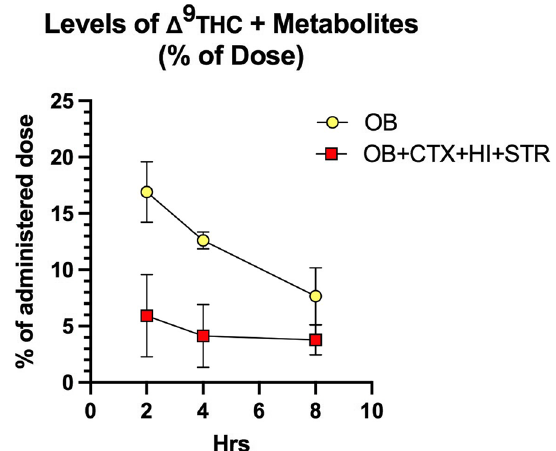
Fig. 5 Percent of administered dose that accumulates in the brain tissues over time. Ratio (expressed as %) of mean OB concentrations to administered dose is shown in yellow circles. Percent of dose accumulated in all 4 brain regions was determined by calculating the ratio of the mean of 4 brain region concentrations of Δ 9 THC metabolites to the administered dose of Δ 9 THC (268 μg/g). Two‑way ANOVA revealed that brain regions contributed 26.9% of total variation (* p <0.005) and time contributed only 9.5% of total variation (NS). OB, olfactory bulb; CTX, cerebral cortex; HI, hippocampus; STR,